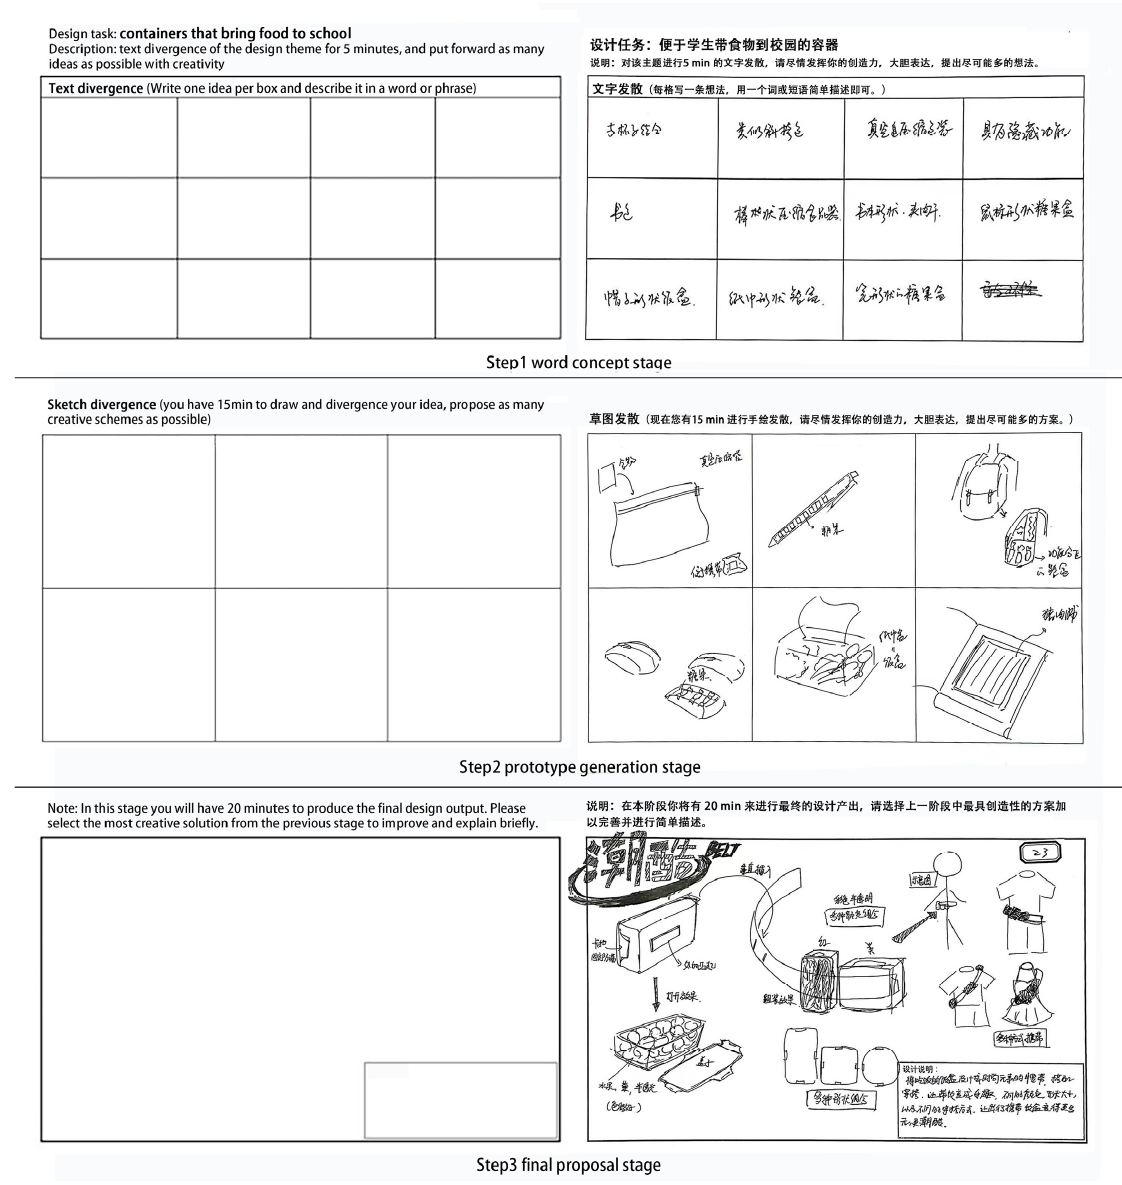
Figure 3. Design method and design example.